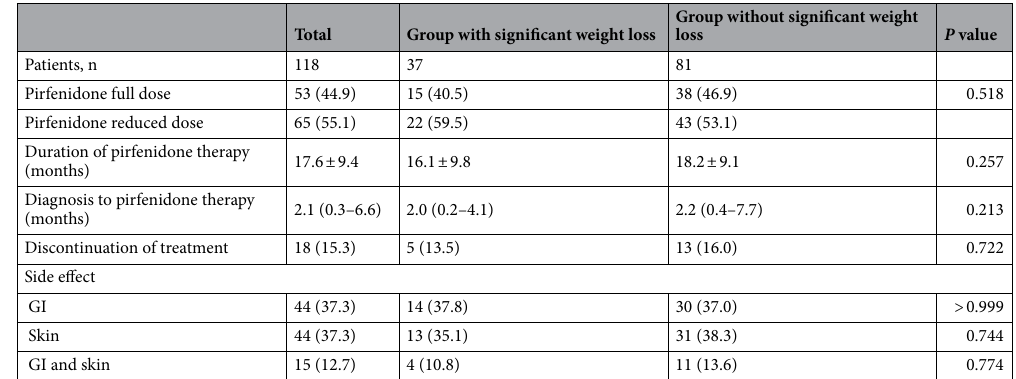
Table 2. Use of pirfenidone and associated side effects in subgroups of patients by weight loss. Data presented as mean ± standard deviation, n (%), median (interquartile range). GI gastrointestinal.